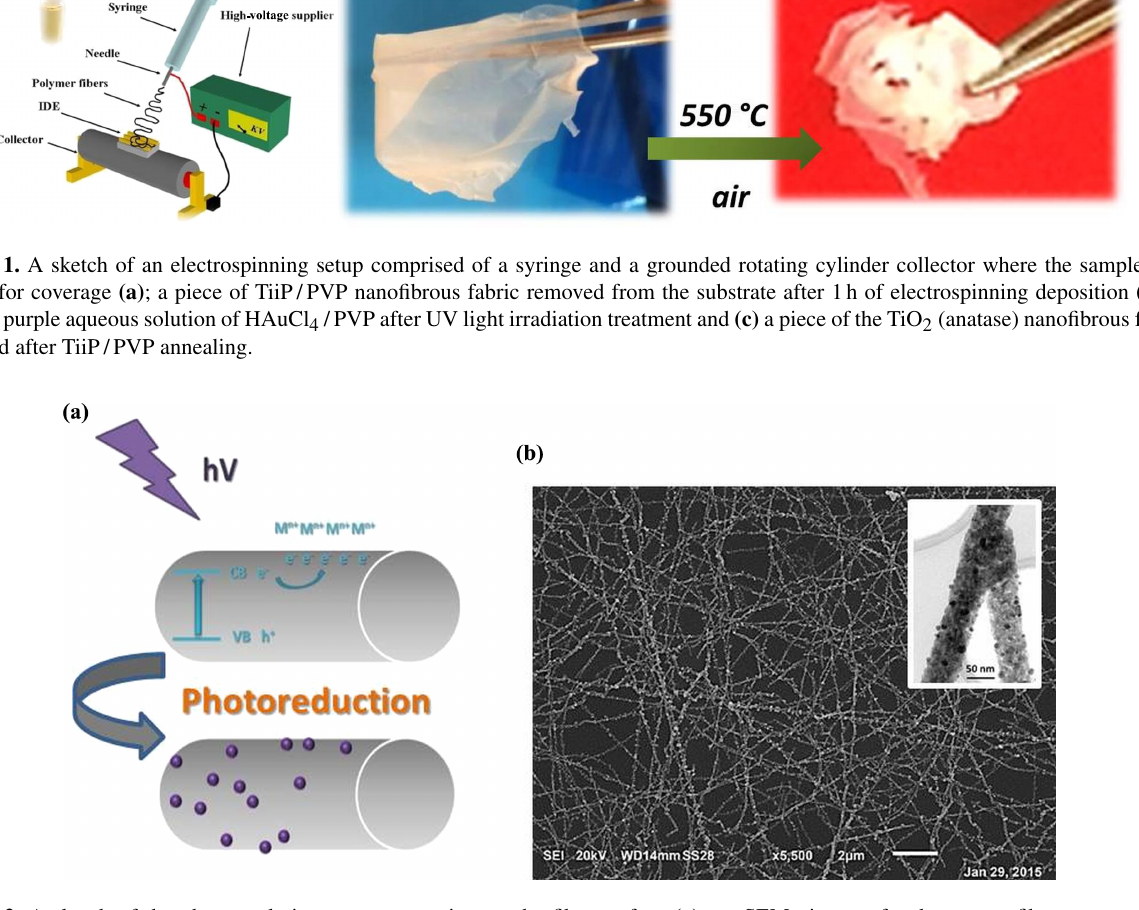
Figure 2. A sketch of the photocatalytic process occurring on the fiber surface (a) ; an SEM picture of a dense nanofibrous network of AuNPs/TiO 2 coating a silicon wafer (b) ; and a C-TEM micrograph of fibers finely decorated with gold nanoparticles (the darkest ones) bound without using any additional linker